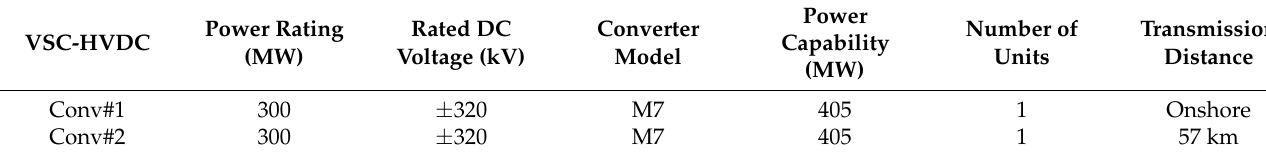
Table A8. VSC/HVDC-converters design for Architecture 3.